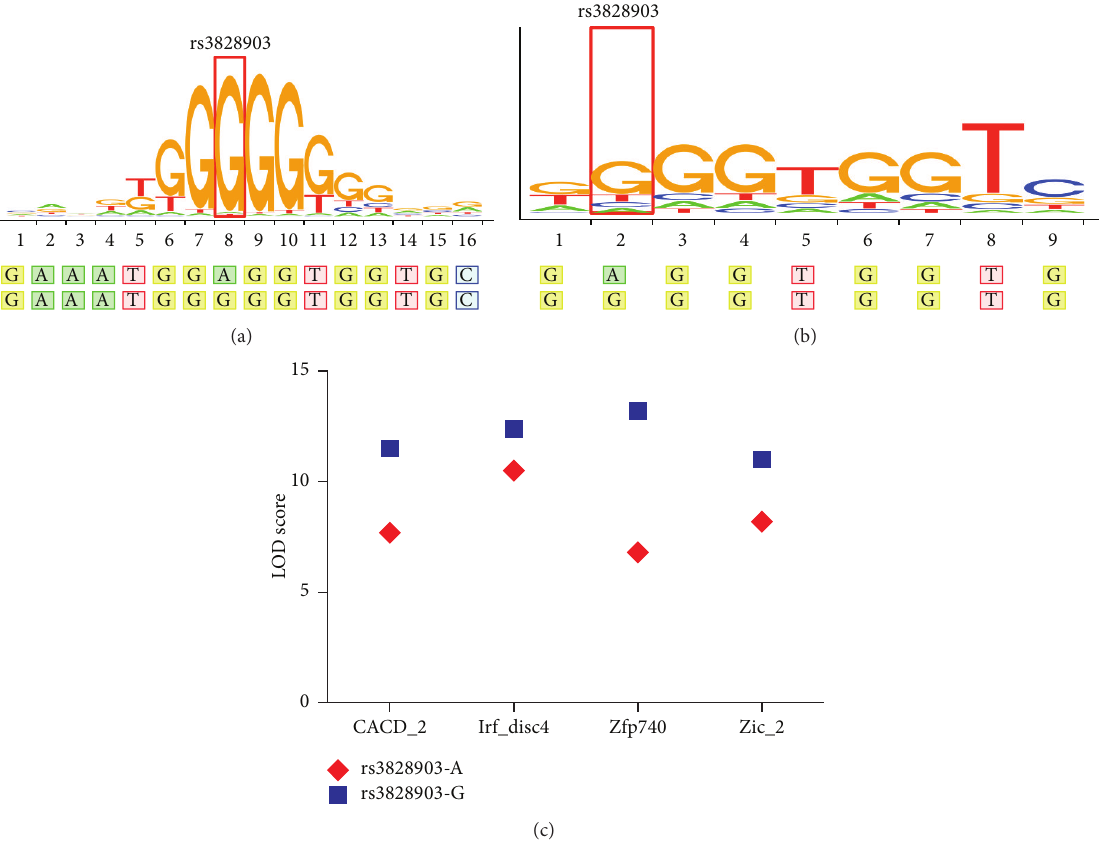
Figure 1: Systemic lupus erythematosus-associated rs3828903 predicted to be part of the motifs for Zfp740 and Zic 2 in both HaploReg v4.1 and RegulomeDB databases. (a, b) Degeneracy within the 16- and 9-base motifs is illustrated at all positions by the stacked letters at each position. The relative height of each letter is proportional to its overenrichment in the motif. A line is boxed around rs3828903-G; this systemic lupus erythematosus-associated risk allele G is predicted to form the 8th and the second nucleotide in the motifs. (c) Altering the rs3828903 allele from rs3828903-G to rs3828903-A decreases the binding affinity for transcription factors CACD 2, Irf disc4, Zfp740, and Zic 2 in HaploReg v4.1